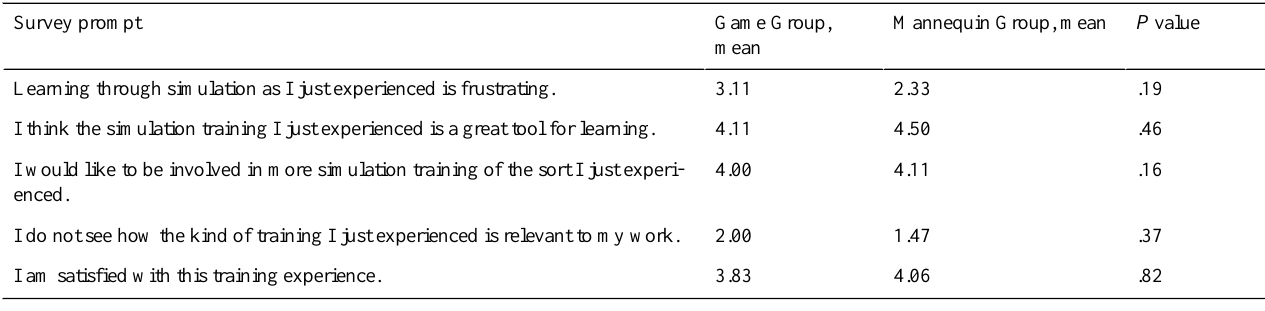
Table 3. Simulation training perception survey results, reported as the average Likert scale responses on scale of 1 (strongly disagree) to 5 (strongly